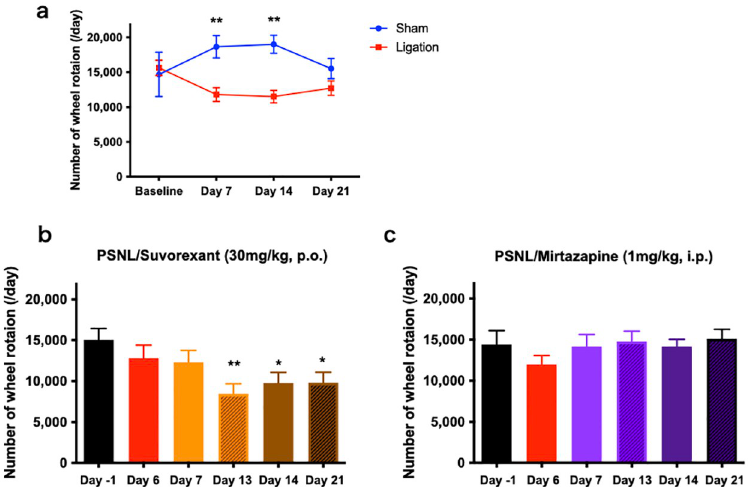
Fig 6. Changes in voluntary activity upon suvorexant and mirtazapine administration following PSNL surgery. The number of rotations in na ï ve mice was evaluated before and 3 weeks after PSNL surgery and compared with the sham group (a). �� P < 0.01, two-way ANOVA with Bonferroni post-test (n = 6). We compared wheel rotations at six different time points with the number in mice treated with each drug at day -1 defined as the baseline (b, c). � P < 0.05, �� P < 0.01, compared with baseline by one-way ANOVA with Bonferroni post-test in suvorexant (b) and mirtazapine (d) experiments (n = 8). Data are expressed as means ± SEMs. Abbreviations: ANOVA, analysis of variance; PSNL, partial sciatic nerve ligation; SEM, standard error of the mean; ZT, Zeitgeber time.